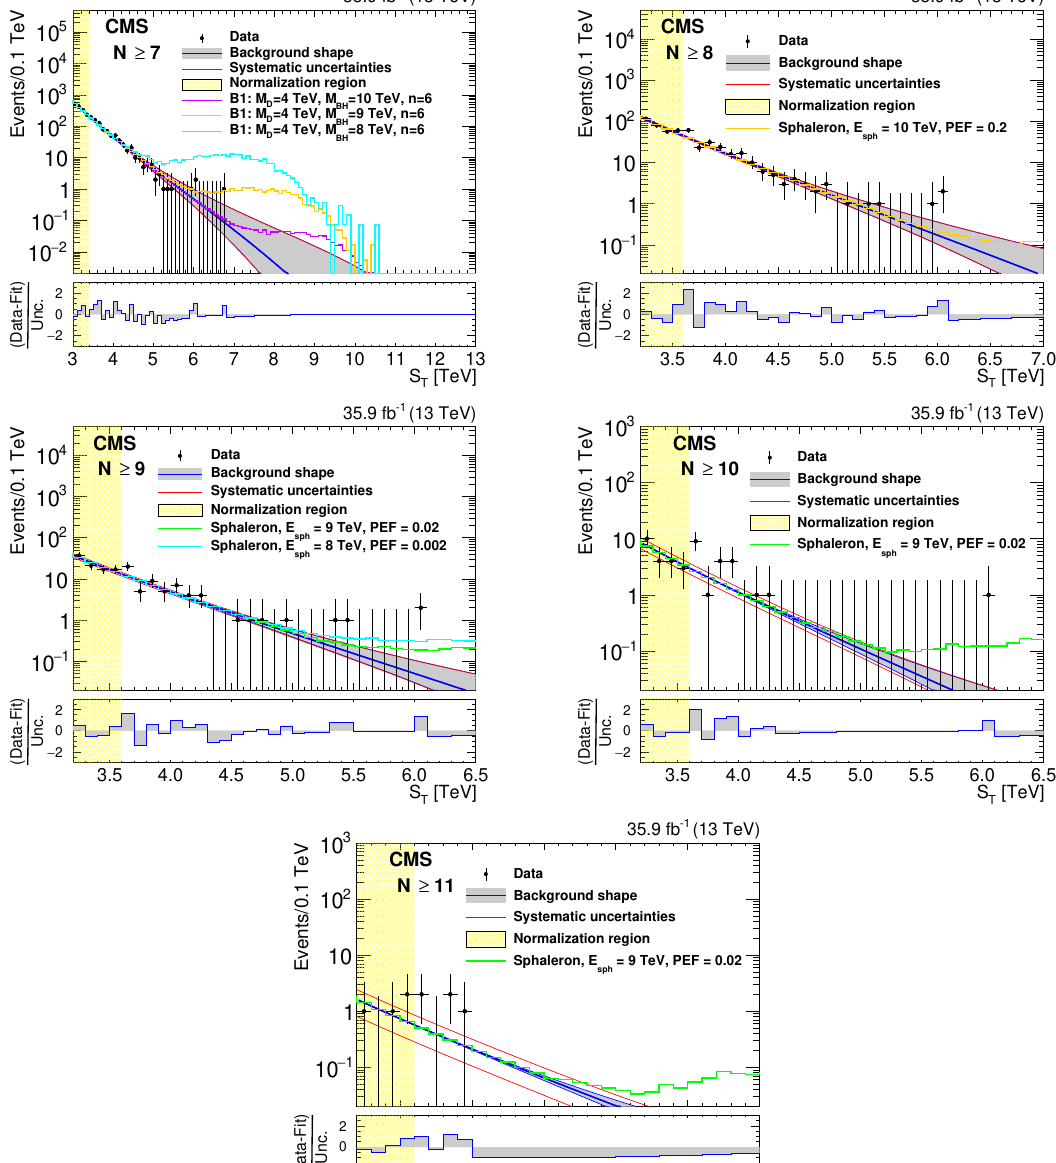
Figure 5 . The comparison of data and the background predictions after normalization for inclusive multiplicities of N (cid:21) 7 ; : : : ; 11 (left to right, upper to lower). The gray band shows the shape uncertainty and the red lines also include the normalization uncertainty. The bottom panels show the di(cid:11)erence between the data and the background prediction from the (cid:12)t, divided by the overall uncertainty, which includes the statistical uncertainty of data as well as the shape and normalization uncertainties in the background prediction, added in quadrature. The N (cid:21) 7 ( N (cid:21) 8 ; : : : ; 11) distributions also show contributions from benchmark BlackMax B1 (sphaleron) signals added to the expected